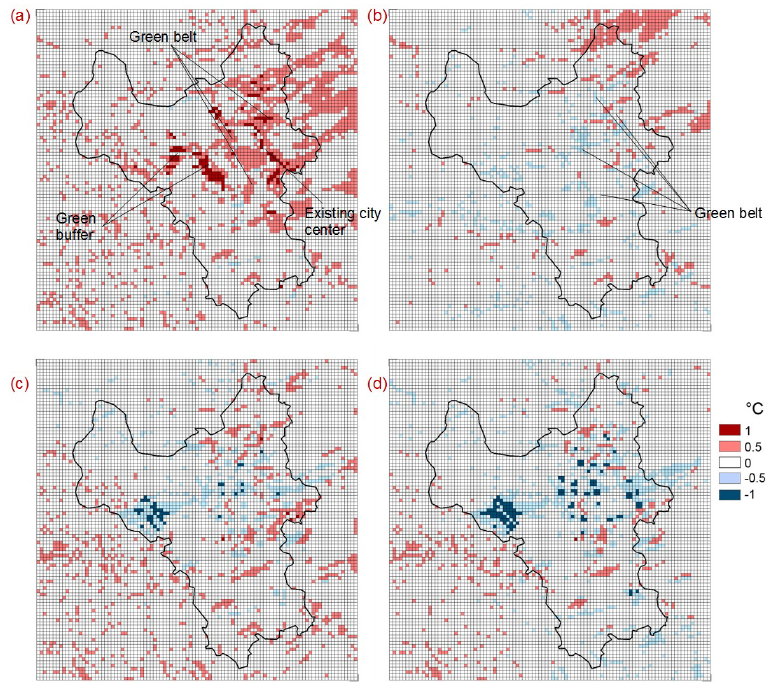
Figure 8. Air temperature difference at 16:00 on 17 June between ( a ) U_HMP-U_NOGREEN;